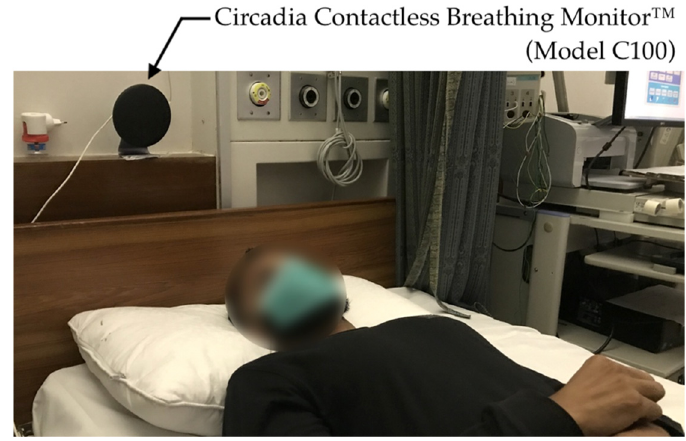
Figure 2. Photo of the Circadia Monitor placement, representative for the experimental setup in Studies 2 and 3.